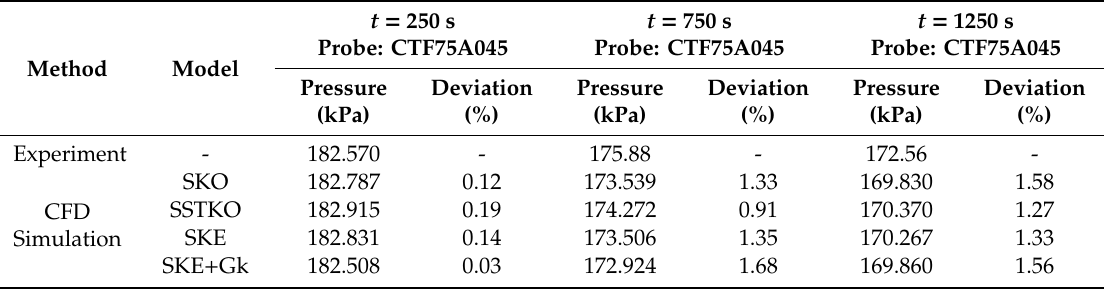
Table 4. Simulation model deviation from the measurement: e ff ect of turbulence models.